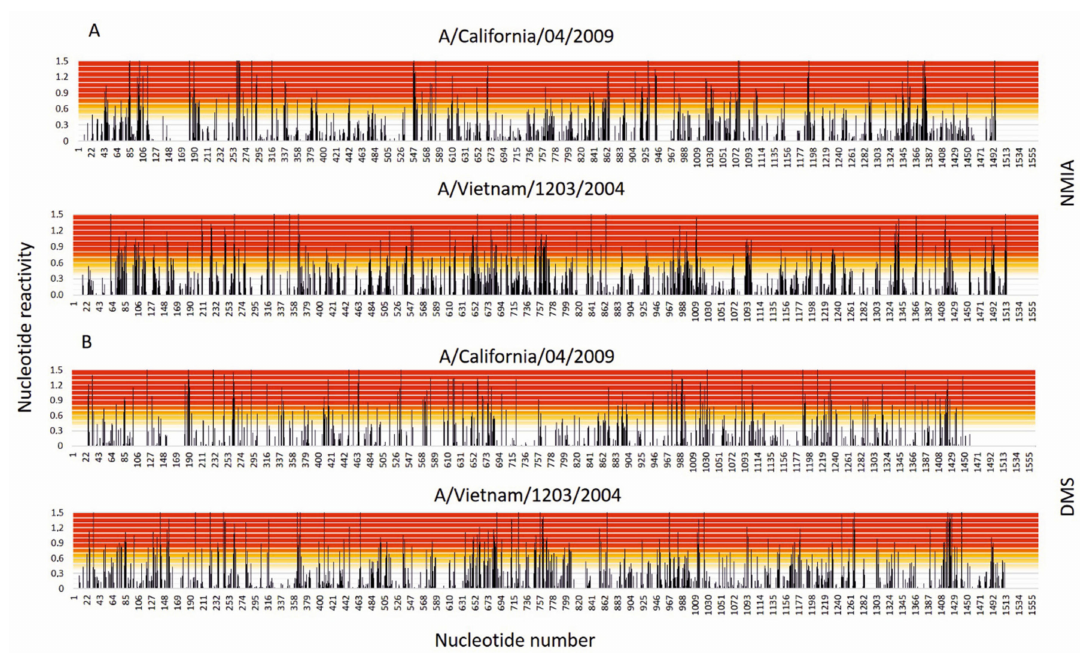
Figure 1. Nucleotide reactivities across vRNA5 in two subtypes of IAV strains ( A , B )—A/California/04/2009 (H1N1) (California) and A/Vietnam/1203/2004 (H5N1) (Vietnam). The colors indicate the reactivity strength–red indicates strong reactivities ≥ 0.7, medium reactivities are marked with yellow 0.7–0.5, while low or no reactivity <0.5 is marked with